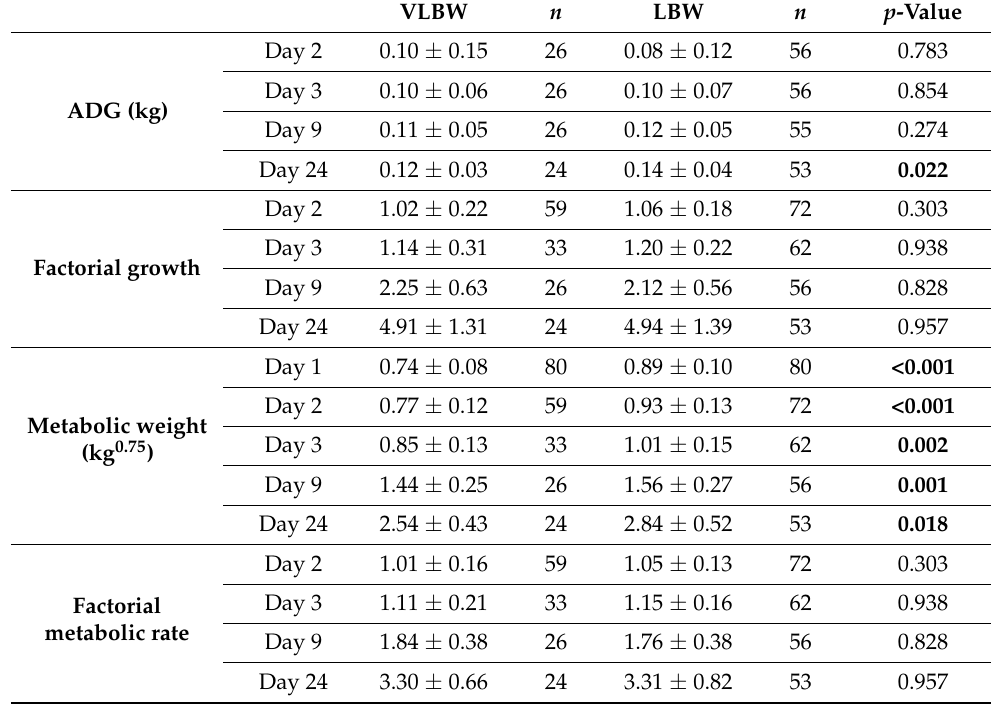
Table 3. Comparison of average daily growth (ADG), factorial growth, metabolic weight and factorial metabolic rate of low birth weight (LBW) with very low birth weight (VLBW) piglets at days 1, 2, 3, 9 and 2 days post-weaning (24 days) at the farm with low perinatal management (Farm A (median ± SD)).